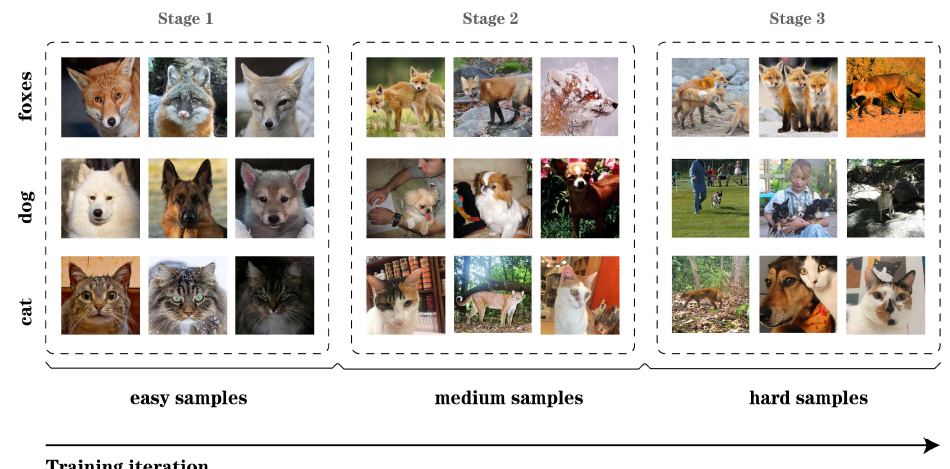
Figure 1. Example of curriculum learning on animal face recognition.